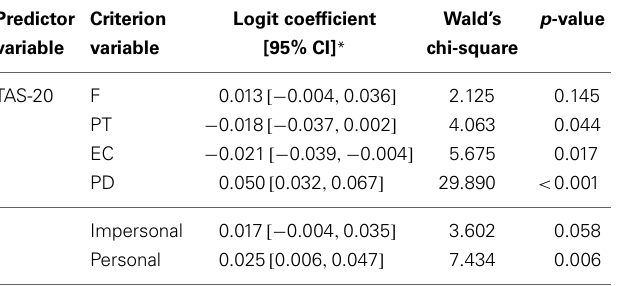
Table 2 | Alexithymia (TAS) scores predicting judgments on moral dilemmas and empathy IRI subscales.